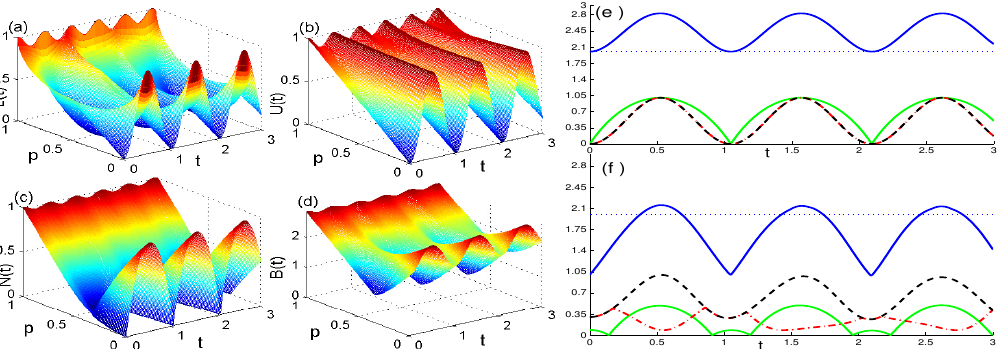
Figure 1. The 3D-evolution of L ( t ) in ( a ), U ( t ) in ( b ), N ( t ) in ( c ) and B ( t ) in ( d ) as functions of the time and the purity indicator p ∈ [ 0,1 ] for χ z = 0.5, ∆ = 1.5, J x = J z = 2 and γ = 0.0. The 2D-evolution of L ( t ) (dashed plots), U ( t ) (dashed dotted plots), B ( t ) (upper solid plots) and N ( t ) (solid plots) for p = 0 in ( e ) and p = 0.3 in ( f